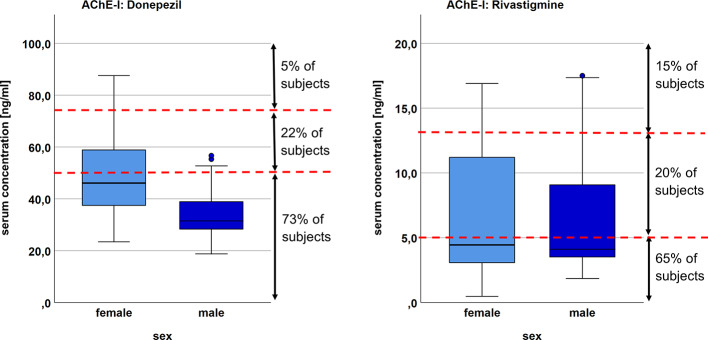
Distribution of serum concentration for female and male subjects in the donepezil and rivastigmine group, respectively. Red dotted line marks the limits of the proposed therapeutic reference range (donepezil 50–75 ng/ml; rivastigmine 5-13 ng/ml (Hiemke et al., 2018).